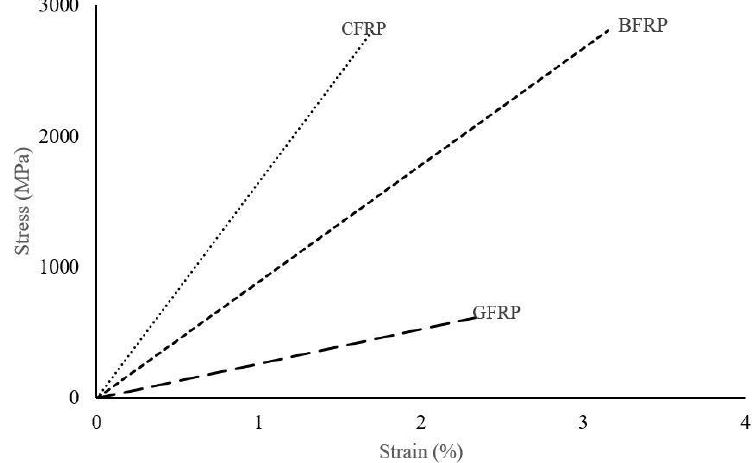
Figure 10. Stress versus strain curves of various fibers [35,36].